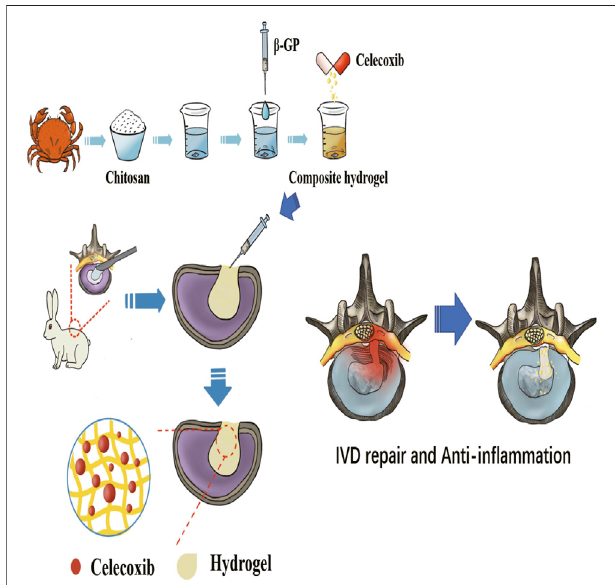
FIGURE 1 | The schematic diagram of the preparation process of thermosensitive injectable celecoxib-loaded chitosan hydrogel and its effect on preventing the recurrence of lumbar disc herniation and pain after partial